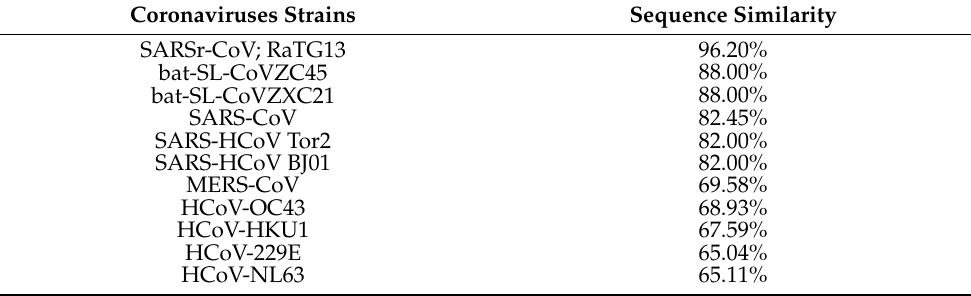
Table 1. Sequence homology between SARS-CoV-2 and other coronaviruses strains [7].